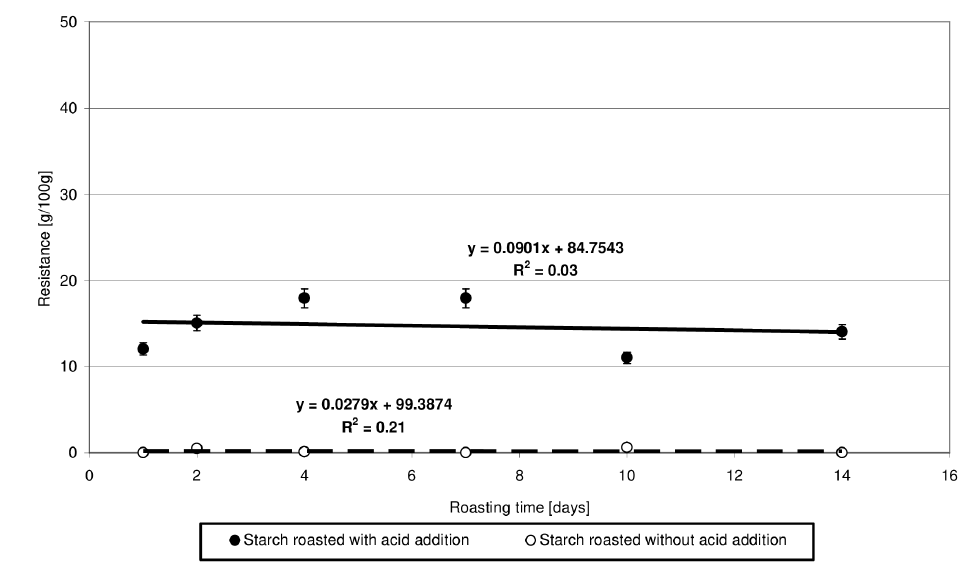
Figure 8. Dependency of resistance on the time of starch retention with and without citric acid.